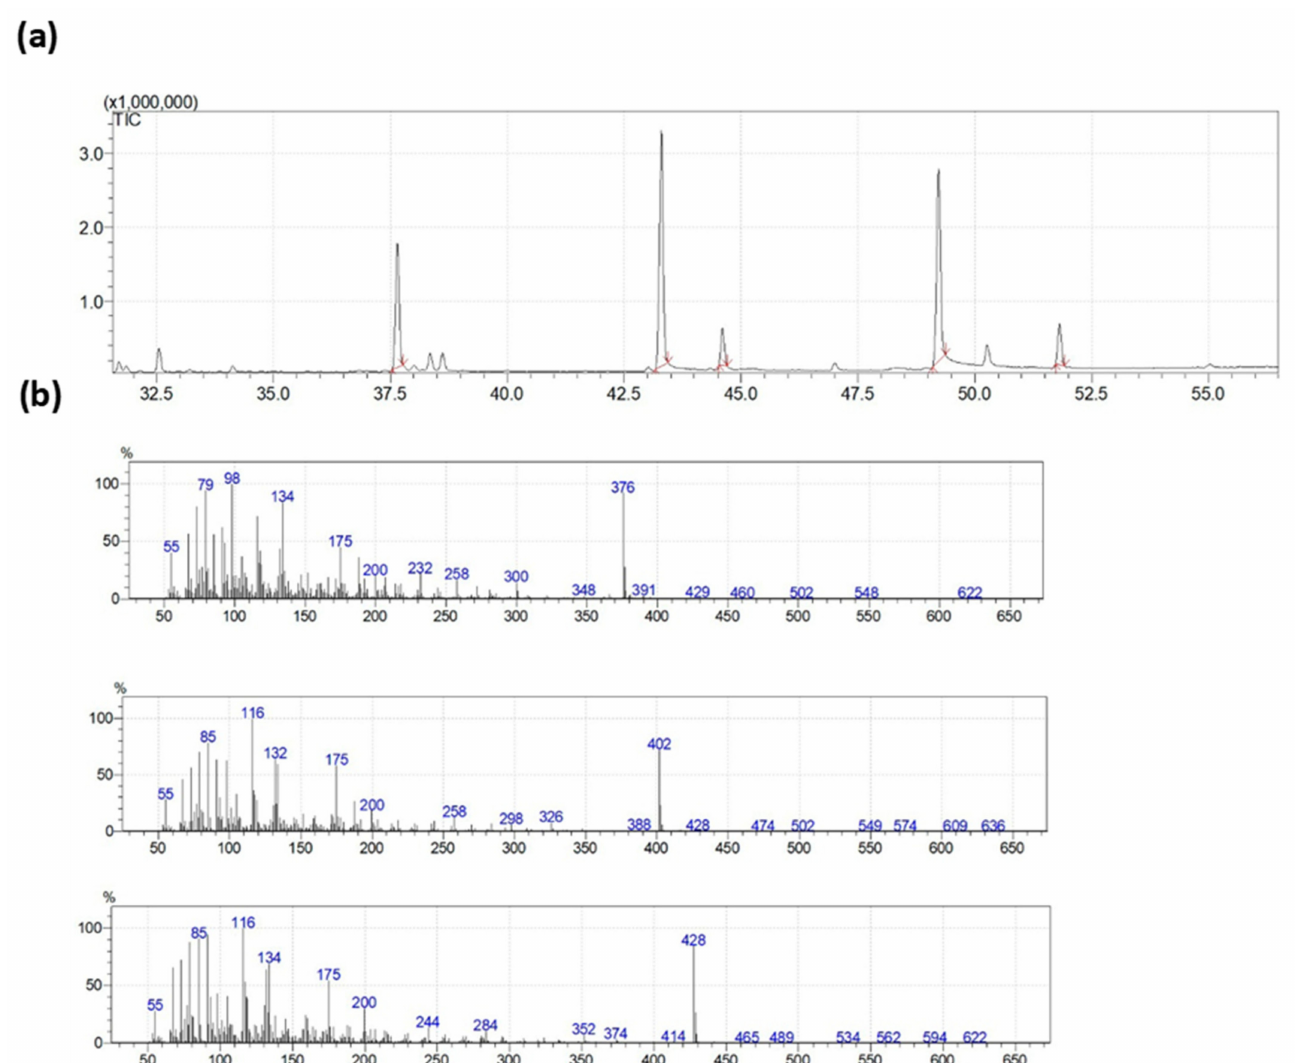
Figure 2. Total ion current chromatogram and electron ionization mass spectra of PUFA ethanolamides trimethyl silyl derivatives included in the composition under study. ( a ) Total ion cur- rent chromatogram of PUFA ethanolamides trimethyl silyl derivatives. ( b ) electron ionization mass spectra of N -stearoylethanolamine trimethylsilyl derivatives ( top ), N -eicosapentanoylethanolamine ( middle ) and N -docosahexanoylethanolamine ( bottom